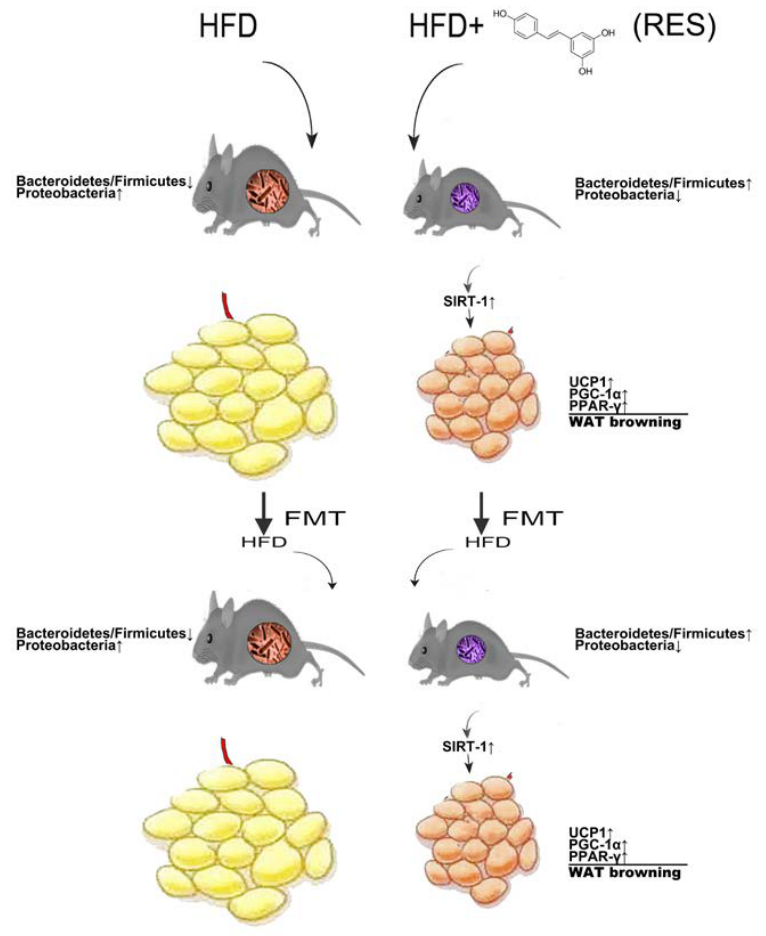
Figure 8. Proposed model for role of resveratrol (RES) in promoting white adipose tissue (WAT) browning in obese mice by remodeling the gut microbiota. RES treatment significantly inhibited increases in fat accumulation and promoted WAT browning in high-fat diet (HFD)-fed mice. Notably, RES supplementation significantly improved dysbiosis induced by HFD. Moreover, the weight- lowering and WAT-browning effects of RES in HFD-fed mice may be due to modulation of the gut microbiota . Supplementary Materials: Figure S1: Study Design Overview, Figure S2: Energy intake in donor groups or recipient